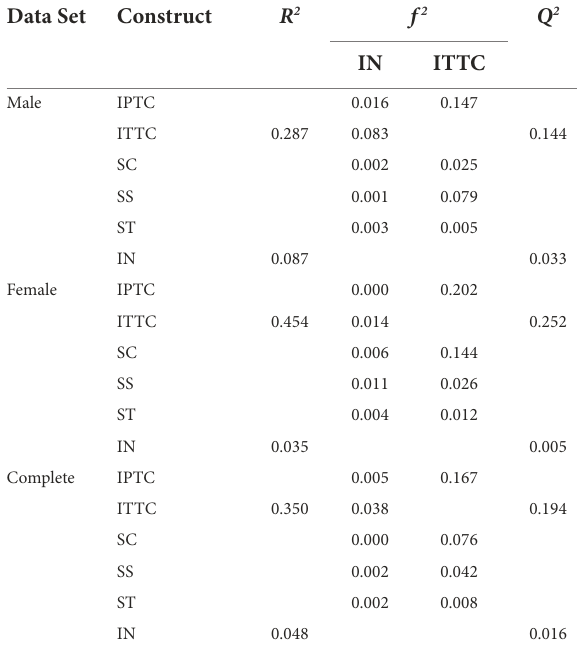
TABLE 7 R 2 , f 2 , and Q 2 . Data